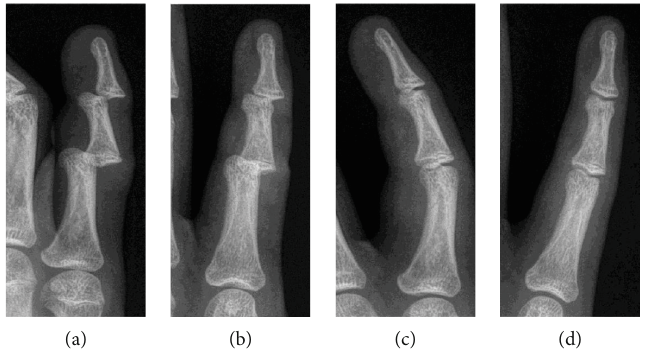
Figure 1: Anteroposterior and lateral radiographs (a, b) of the index fi nger showing dorsal dislocation of both the proximal and distal interphalangeal joints, without any bony avulsion fracture. Postreduction anteroposterior and lateral radiographs (c, d) con fi rm that all joints are well reduced.